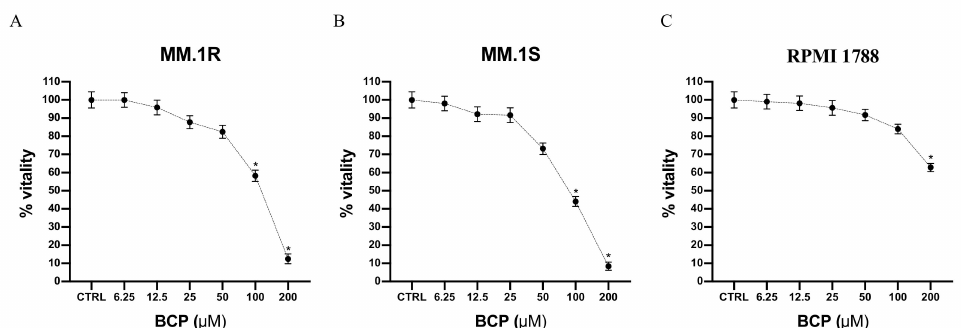
Figure 1. Cell viability evaluated in MM.1R ( A ), MM.1S ( B ), and RPMI 1788 ( C ) cell lines treated with BCP using MTT assays. Values are expressed as percentages of viability reduction compared with control cells. The data are expressed as means ± SEM; n = 3 experiments; * p < 0.05 vs.